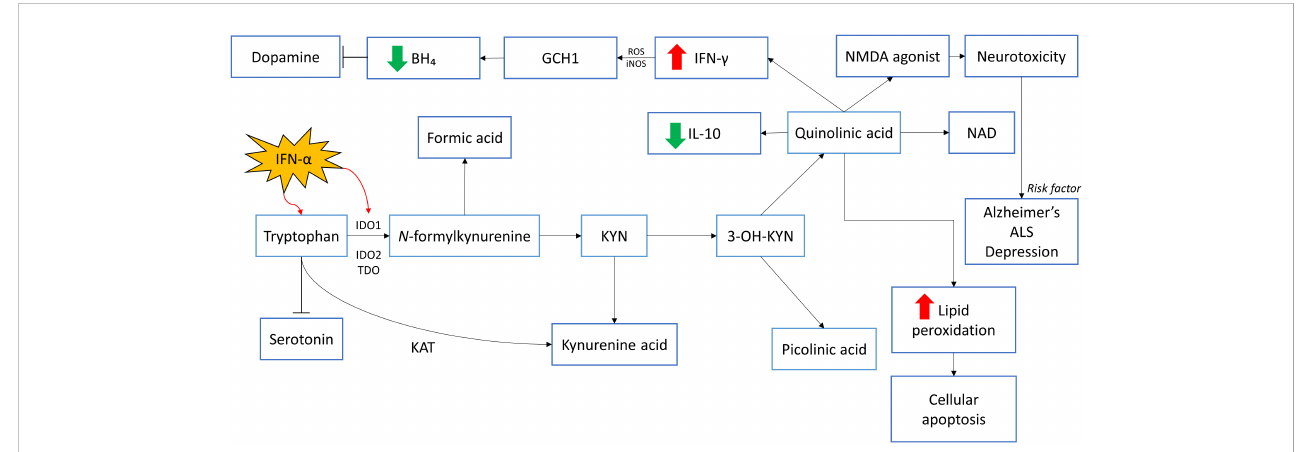
FIGURE 1 The roles of neurotransmitters in IFN-induced mood dysregulation. IFN- a stimulates IDO1 activity, stimulating the conversion of tryptophan to kynurenine and affects the synthesis of serotonin. Through several pathway metabolisms, kynurenine will be converted to quinolinic acid and picolinic acid. Quinolinic acid decreases the level of IL-10 which has anti-in fl ammatory effects. The negative effects of quinolinic acid include increasing the levels of IFN- g which causes in fl ammation. This in fl ammatory response result in the production of ROS and iNOS which decreases BH ₄ . This eventually reduces dopamine secretion. Quinolinic acid is an NMDA agonist and can cause neurotoxicity as seen in patients with Alzheimer ’ s disease, ALS and depression. Quinolinic acid could cause cellular apoptosis too through the increase in lipid peroxidation. * IDO1: Indoleamine 2,3-dioxygenase 1; IDO2: Indoleamine 2,3-dioxygenase 2; TDO2: tryptophan 2,3-dioxygenase; KYN: Kynurenine; NAD: Nicotinamide adenine dinucleotide; NMDA: N-methyl-D-aspartate; IL- 10: Interleukin-10; IFN- g : Interferon-gamma; IFN- a : Interferon-alpha; ROS: Reactive oxygen species; iNOS: Inducible nitric oxide synthase; GCH1: GTP cyclohydrolase I; BH ₄ : Tetrahydrobiopterin; KAT: Kynurenine aminotransferase